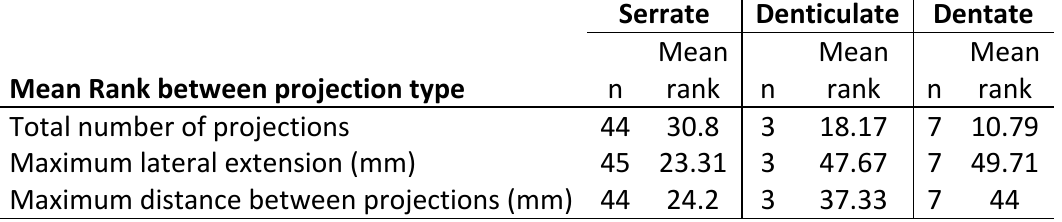
Table 5. Mean rank for projection types and morphological measures. Abbreviations: * test excludes those points with more than 30% broken projections, seeing 13